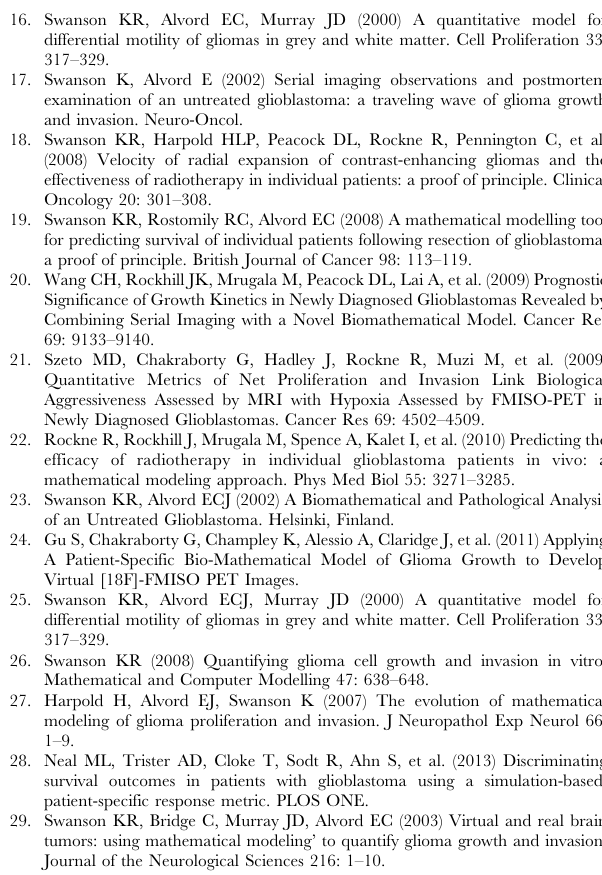
Table S1 Cox Proportion-Hazards Regression for Co- horted Survival